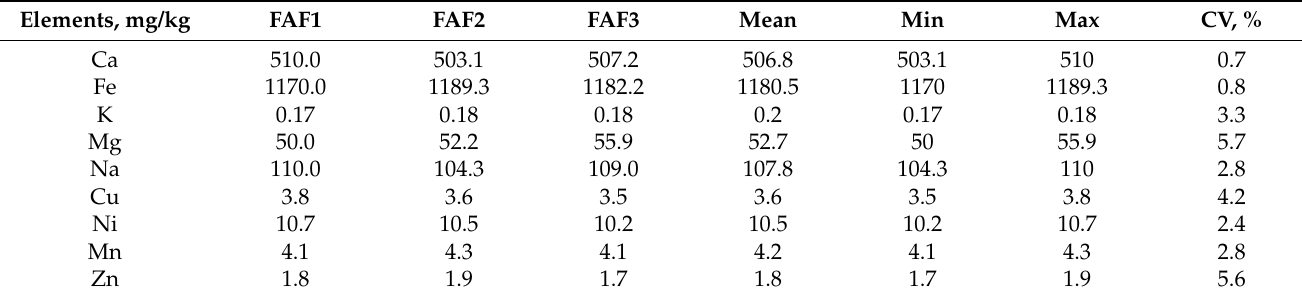
Table 5. Detection of major, minor elements, and heavy metals in Matricaria recutita white ray floret supercritical fluid